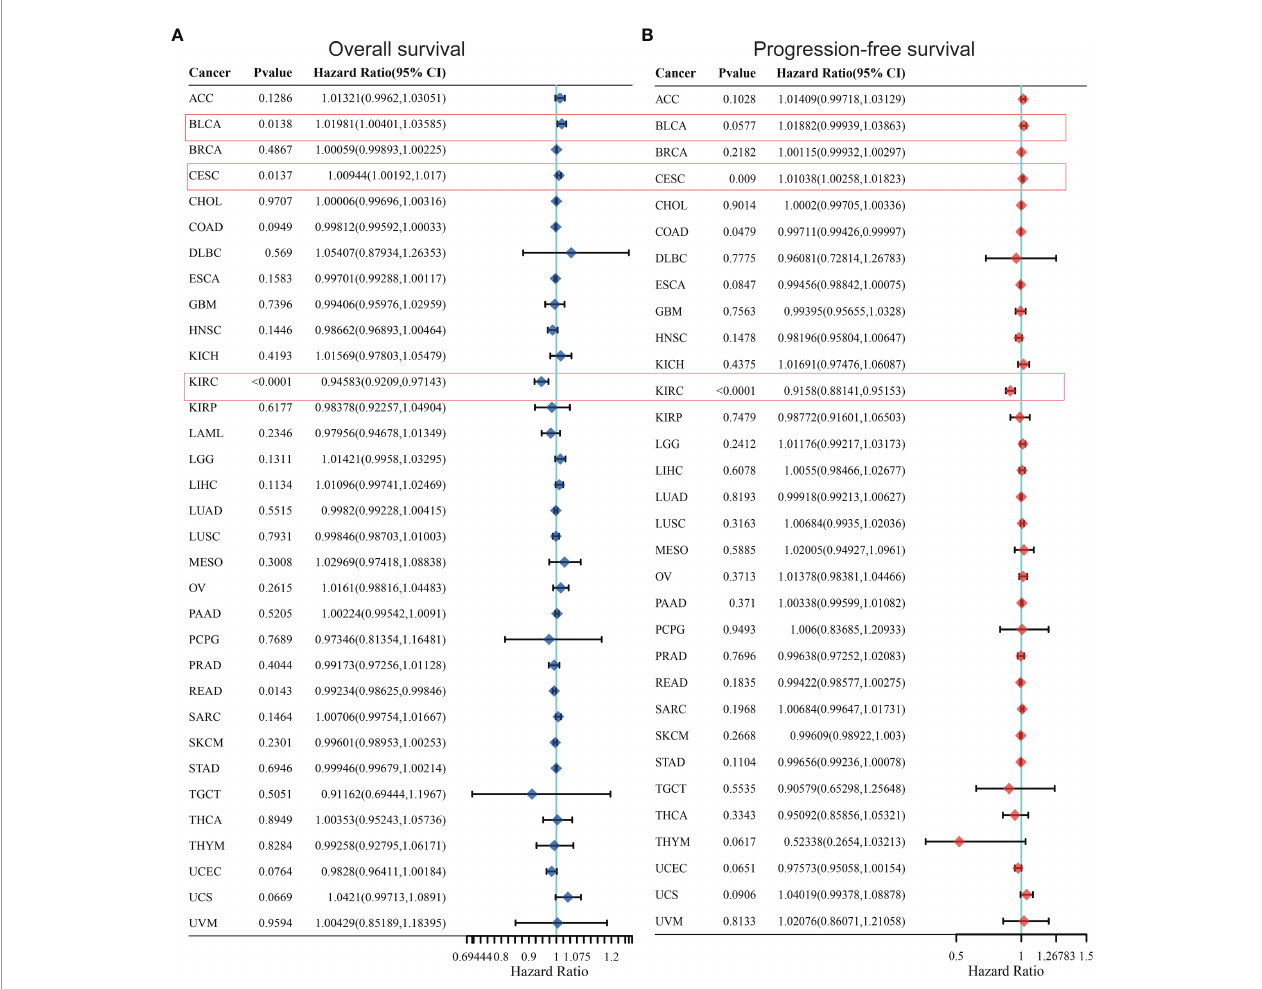
FIGURE 3 | Prognostic prediction of NKCC1 for overall survival (A) and progression-free survival (B) in pan-cancer. BLCA (OS, p = 0.0138; PFS, p = 0.0577), CESC (OS, p = 0.0137; PFS, p = 0.009), and KIRC (OS, p < 0.0001; PFS, p < 0.0001). BLCA, Bladder Urothelial Carcinoma; CESC, Cervical squamous cell carcinoma and endocervical adenocarcinoma; KIRC, Kidney renal clear cell